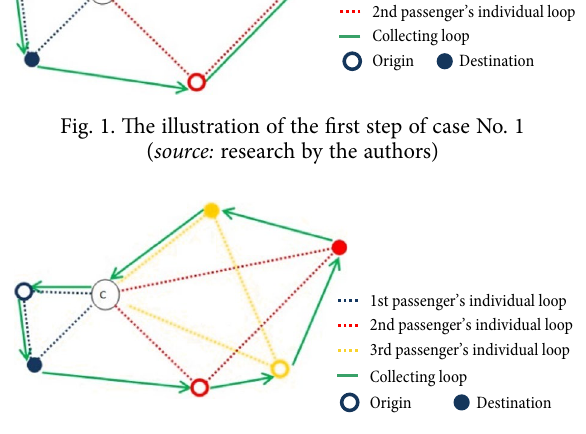
Fig. 2. The illustration of the second step of case No. 1